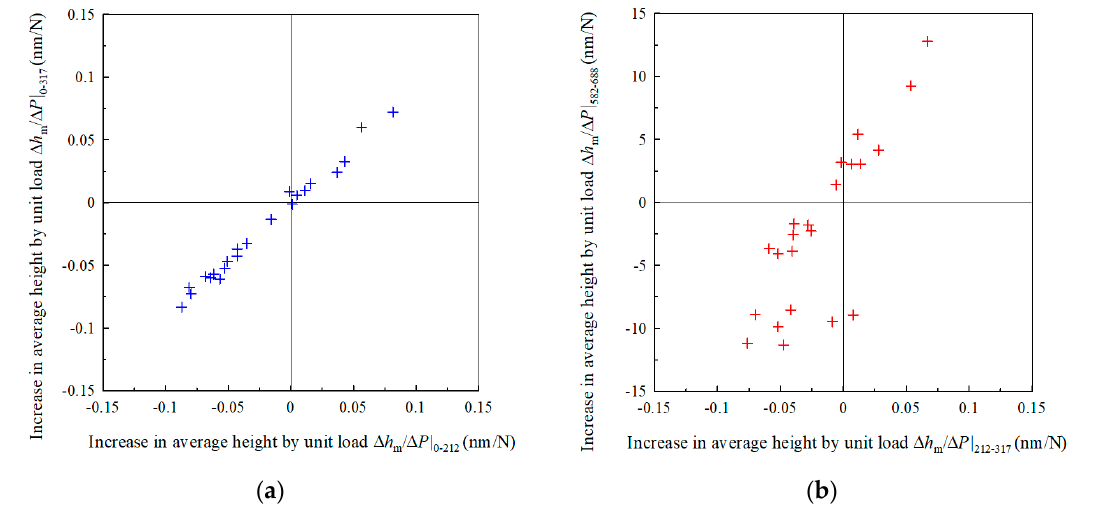
Figure 11. Relationship between average height change per unit load under elastic and plastic loading conditions [19]. ( a ) Between P = 0 N and P = 212 N (abscissa) and P = 0 N and P = 317 N (ordinate) load steps; and ( b ) between P = 212 N and P = 317 N (abscissa) and P = 582 N and P = 688 N (ordinate) load steps.